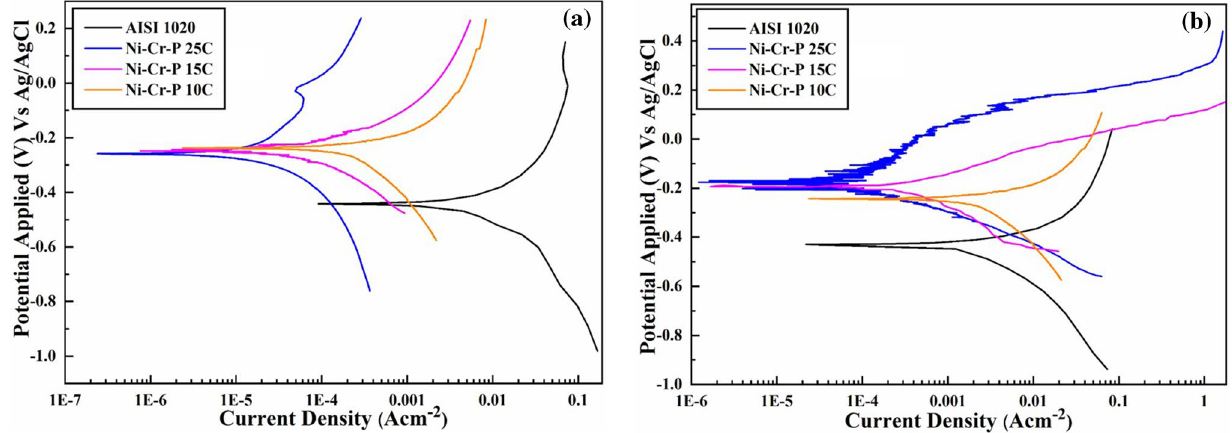
Fig. 7 Potentiodynamic polarization behavior of AISI 1020 low-carbon steel and Ni–Cr–P coated samples, electrodeposited at various tempera- tures, in 0.5 M H 2 SO 4 and 2 ppm HF at 80 °C and scan-rate 0.1 mV/s, a anodic (H 2 purging) environment, b cathodic (air purging)